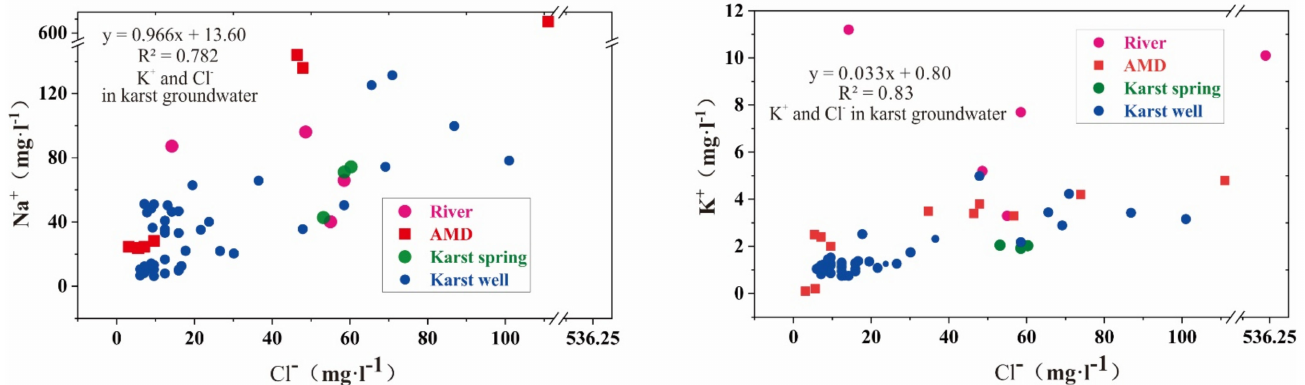
Figure 9. Relationships between ( a ) K + vs. Cl − in karst groundwater ( b ) Na + vs. Cl − in karst groundwater.